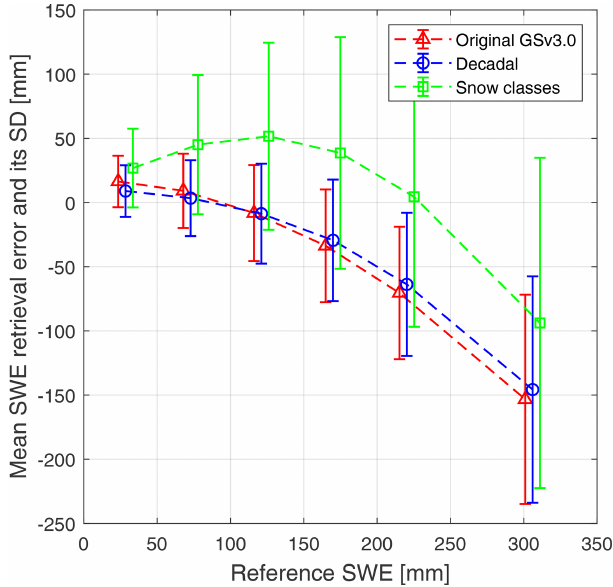
Figure 11. Comparisons of the mean error and standard deviations between baseline and datasets post-processed with decadal snow densities and densities based on fixed snow classes according to Sturm et al.